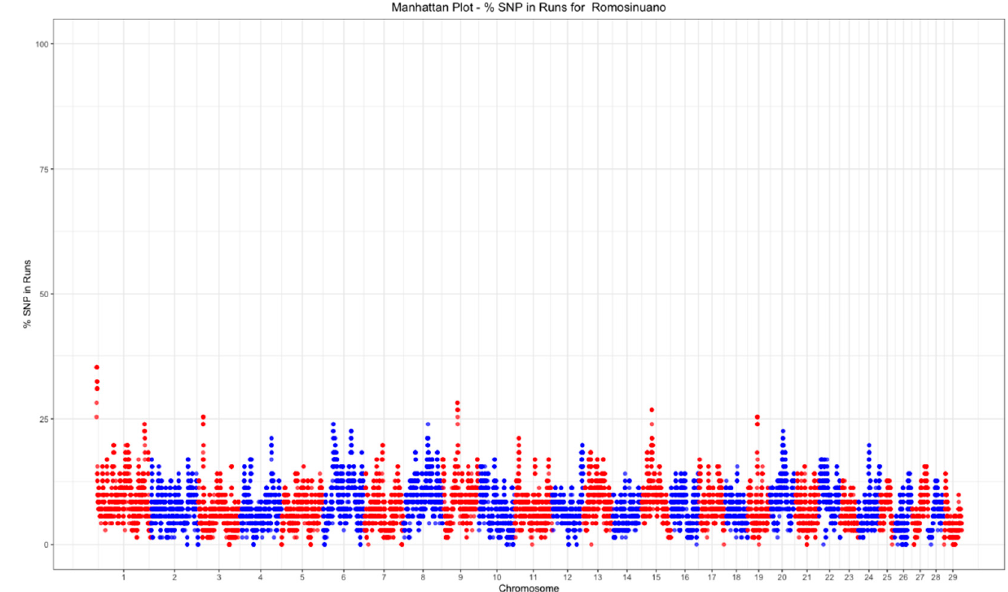
Figure 6. Manhattan plot of the SNP frequency within runs of homozygosity by autosome in the Mexican Romosinuano beef cattle population.